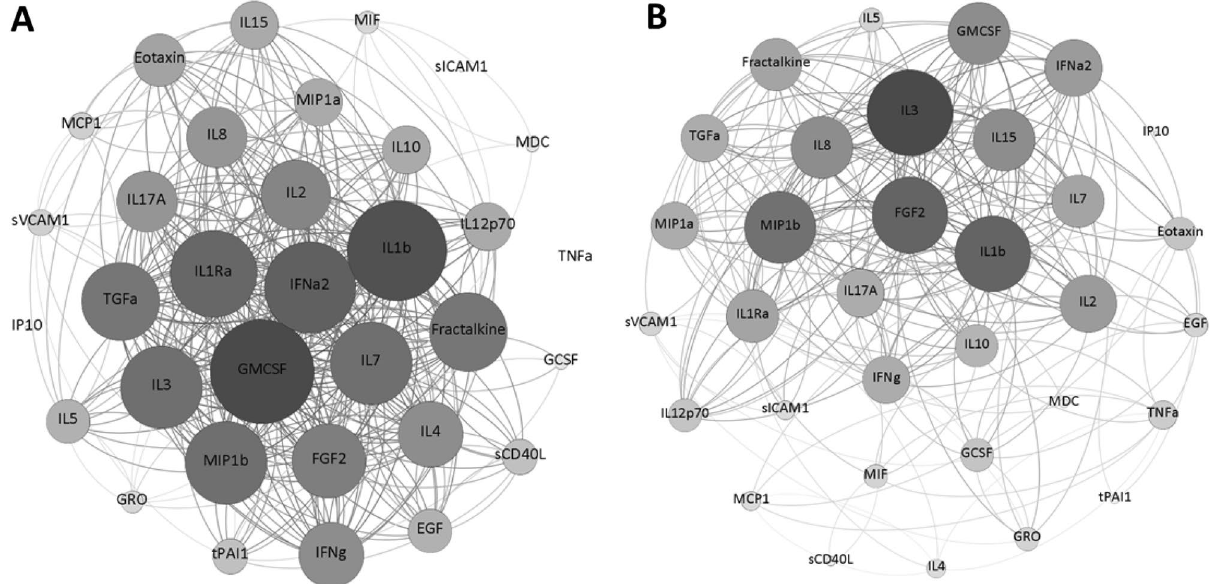
Figure 3. Inter-cytokine correlation networks in symptomatic and asymptomatic carotid stenosis. Force- directed graphs using Fruchtermann–Reingold-Algorithm depicting plasma inter-cytokine correlations in symptomatic ( A ) and asymptomatic ( B ) carotid stenosis at 90 days